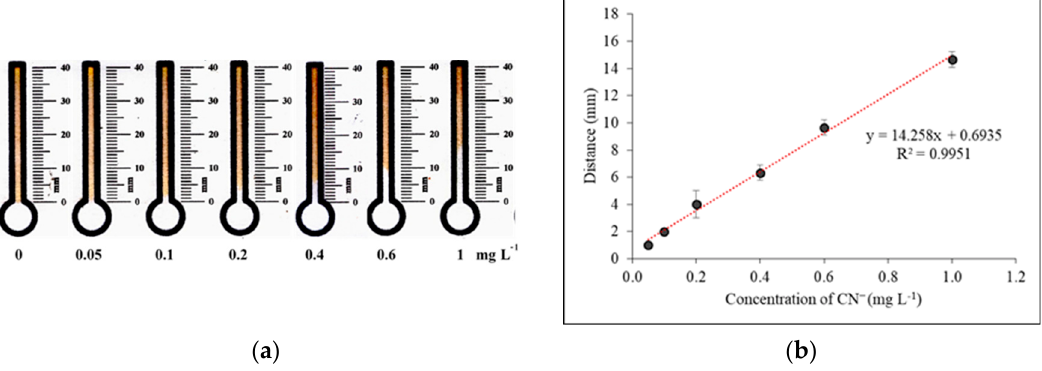
Figure 5. ( a ) Result images of CN − determination in the range of 0.05 – 1 mg L − 1 with head-space extraction on dPADs and ( b ) Calibration curve for CN − determination in the range of 0.05 – 1 mg L − 1 with head-space extraction on dPADs.